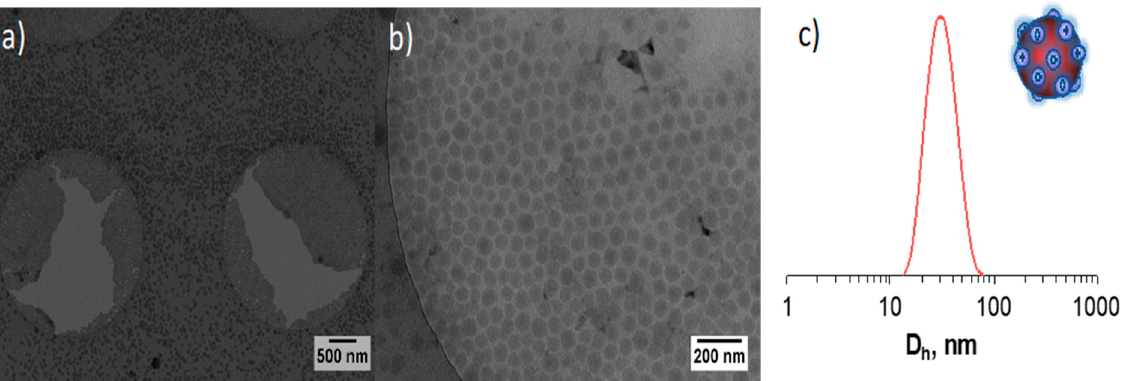
Figure 1. Cryo-TEM image ( a , b ) of polymeric nanoparticles in solution showing the formation of spheres. ( c ) Hydrodynamic size distribution of polymeric nanoparticles.